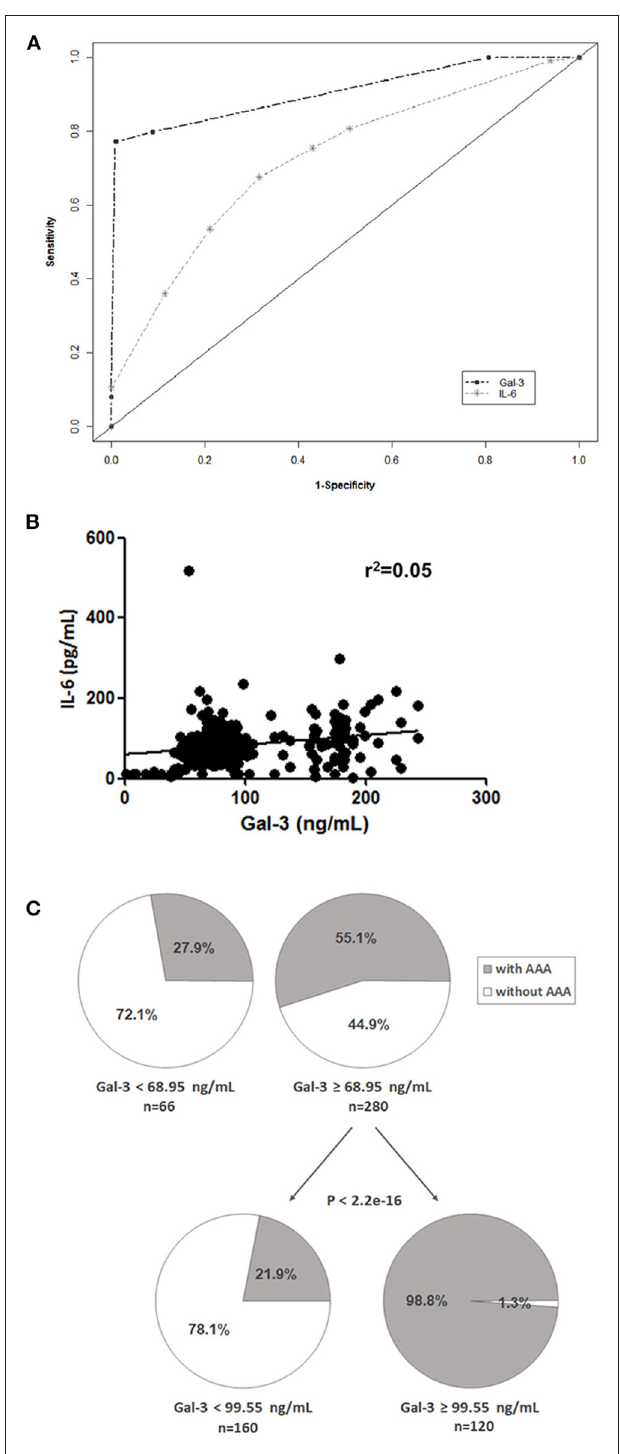
FIGURE 2 | Potential prognostic value of Gal-3. (A) Receiver operating characteristic curves of Gal-3 and IL-6 were used to differentiate patients with AAA from control patients. (B) Correlation between Gal-3 and IL-6 levels in patients with AAA and control patients. (C) CART analysis with plasma Gal-3 levels as the independent variable and AAA as the dependent variable (all patients included).